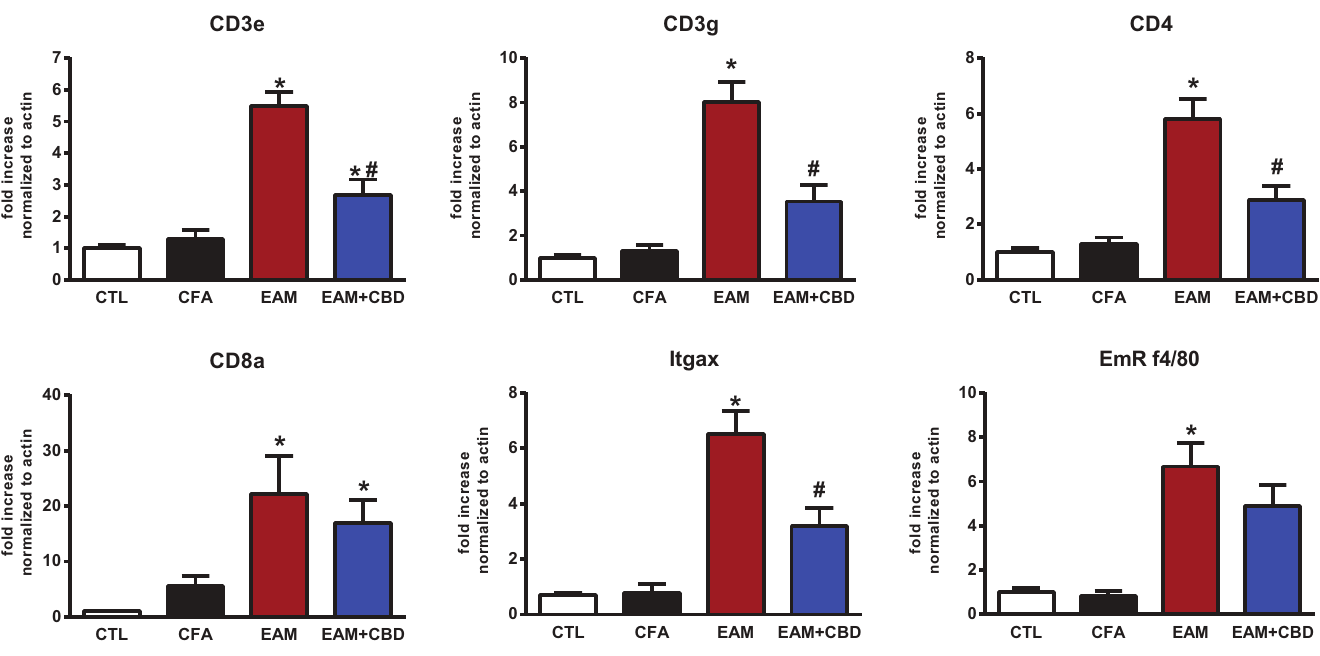
Figure 2. Effects of CBD treatment on inflammatory cell markers in EAM. The graphs show the mRNA gene expression of CD3e, CD3g, CD4, CD8a, Itgax and EmR f4/80 in experimental autoimmune myocarditis. * P < 0.05 versus CTL; # P < 0.05 versus EAM.